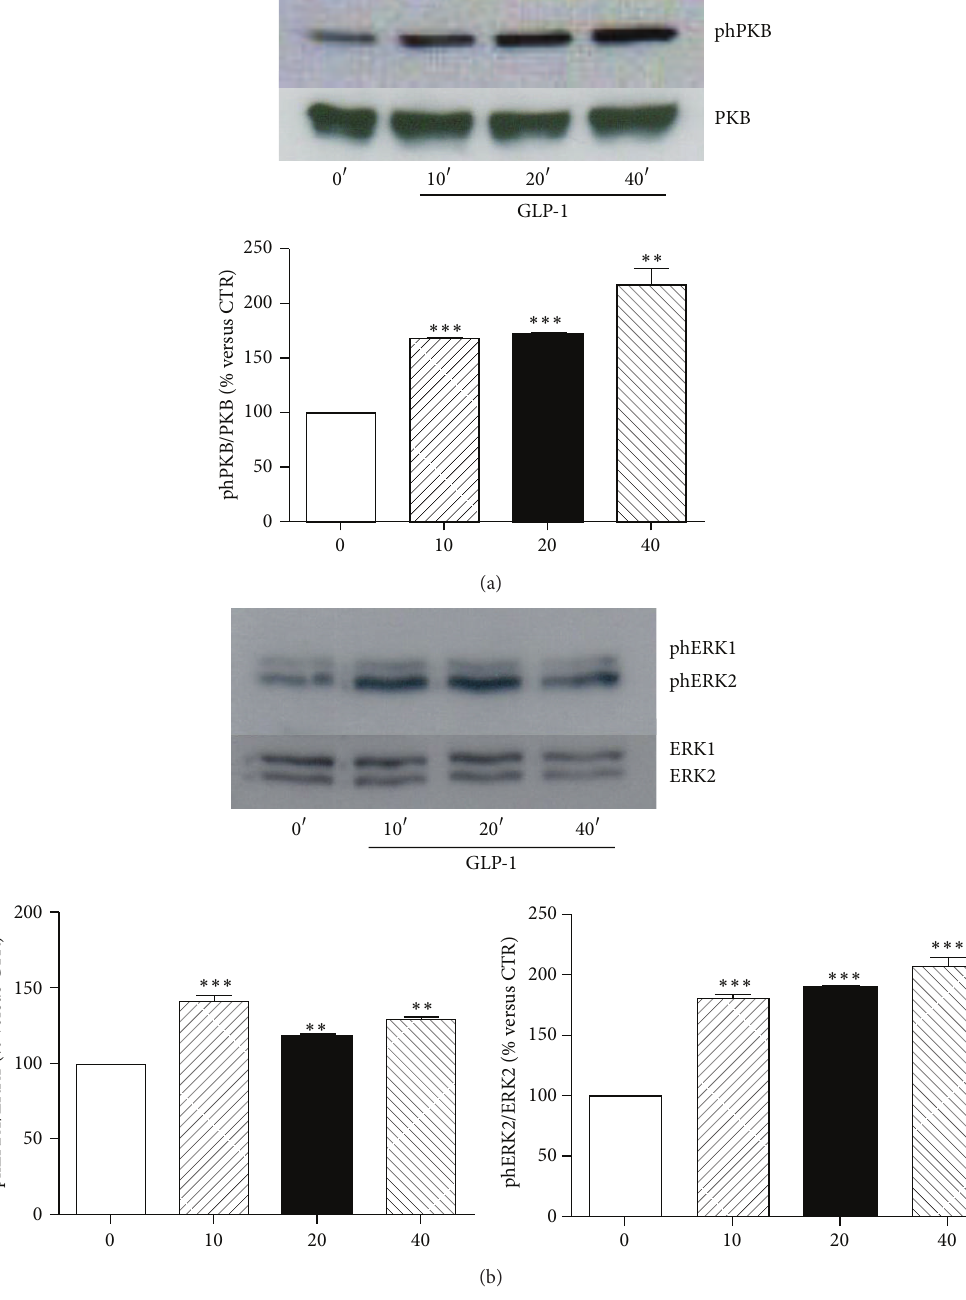
Figure 3: GLP-1 phosphorylates the intracellular signalling proteins PKB and ERK1/2. ARPE-19 cells were cultured in serum-free medium for 24 hours and stimulated with control medium (0 󸀠 ) or for 10, 20, and 40 minutes with 10nmol/L GLP-1. Then, cells were then lysed and tested for phosphorylation and total protein of PKB (a) and ERK1/2 (b). Upper panel: representative western blot analysis of three different experiments is shown. Lower panel: densitometries of western blot bands. Data were expressed as mean ± SE of fold induction relative to total protein ( 𝑛 = 3 ). ∗∗ 𝑃 < 0.01 and ∗∗∗ 𝑃 < 0.001 versus time 0 󸀠